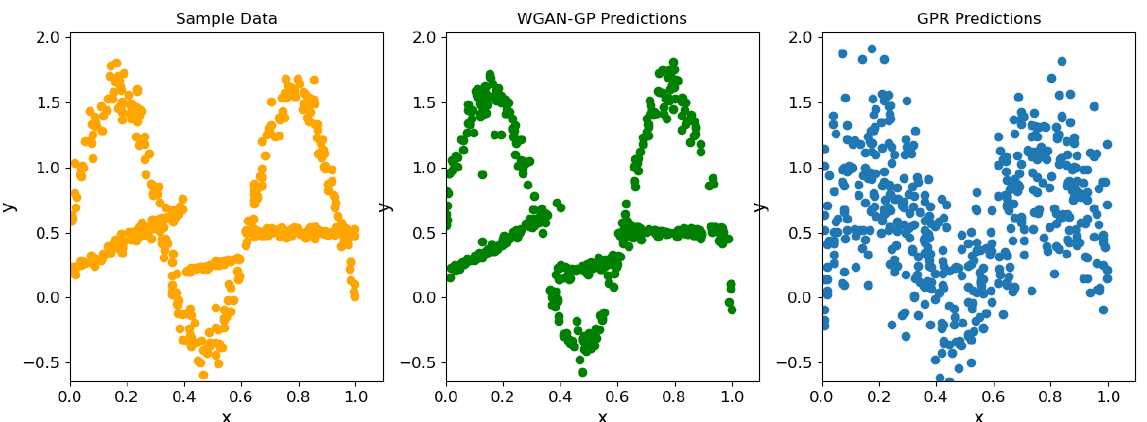
Figure 7. A sine wave intersected by several lines. The test data is shown on the left, sampled points from the WGAN are shown in the middle and sampled points from the GPR posterior are shown on the right.